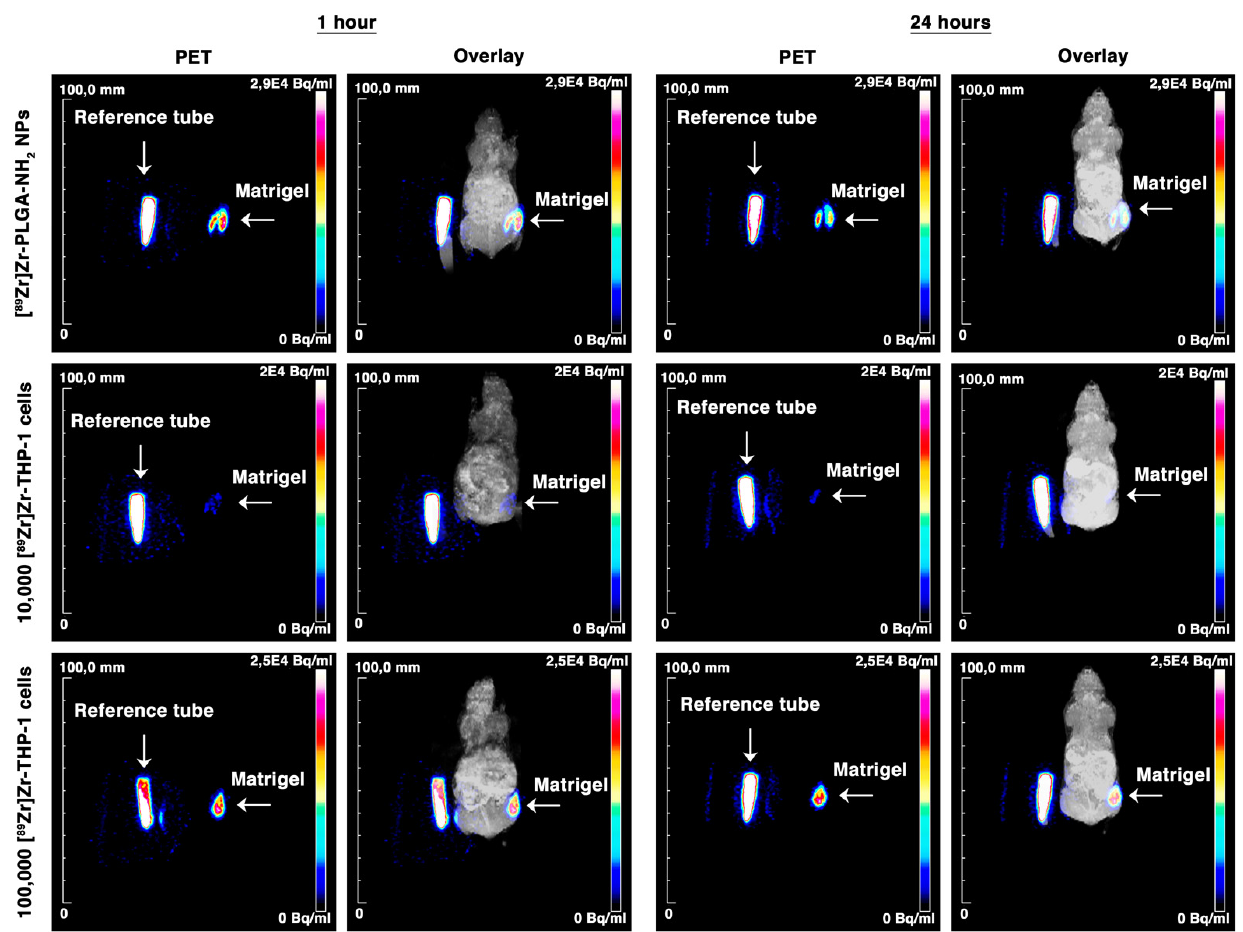
Figure 6. PET and MRI images of subcutaneous injected [ 89 Zr]Zr-THP-1 cells in BALB/cAnNRj-Foxn1nu/Foxn1nu mice. Mice were subcutaneously injected with Matrigel containing [ 89 Zr]Zr-PLGA-NH 2 , 10,000 [ 89 Zr]Zr-THP-1 cells or 100,000 [ 89 Zr]Zr-THP-1 cells. PET and MRI scans were performed after 1 and 24 h. The reference tube contains 10% of the injected dose. Brightness (+100 points) and contrast (+70 points) were increased for better visualization, with Adobe Photoshop, in all the